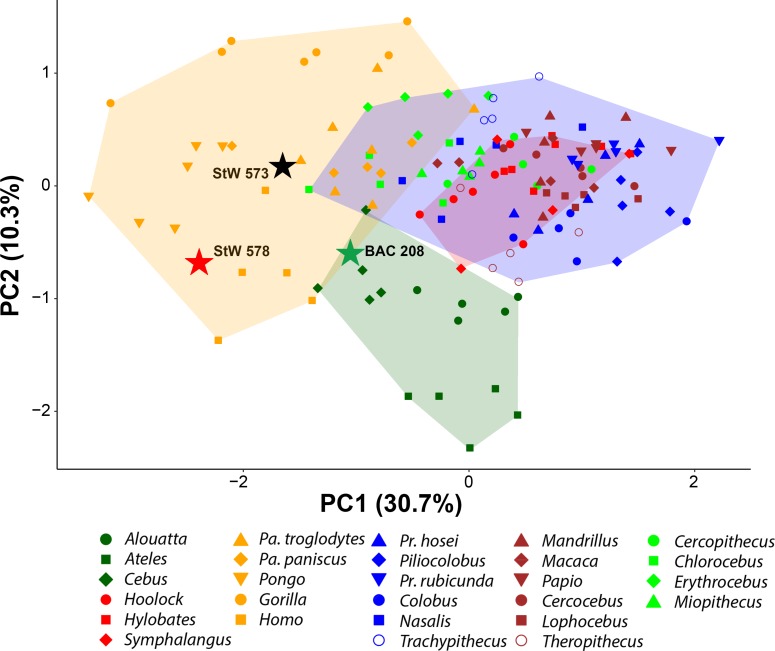
Tangent space of vestibular shape among the analyzed anthropoid sample as shown by bivariate plots of principal components from the PCA of deformation-based analysis.Variance explained by each PC is included within parentheses. Convex hulls correspond to: hominids (orange), hylobatids (red), cercopithecoids (blue), platyrrhines (green). Color code: dark green, platyrrhines; orange, hominids; red, hylobatids; brown, papionins; green, cercopithecins; blue, colobines. Hominids are distinguished from hylobatids and other anthropoids along PC1 (mostly negative vs. positive values, respectively), while PC2 tends to distinguish platyrrhines (more negative values) from catarrhines. Even if slightly more overlapping, the groups identified when observing the morphospace obtained with bgPCA are already present in the PCA.Figure 8—source data 1.Individual scores for all the principal components (PC) yielded by the principal components analysis (PCA) of deformation-based 3DGM of vestibular shape for anthropoids.The variance explained by each PC is reported. Table provided as a separate Excel file.